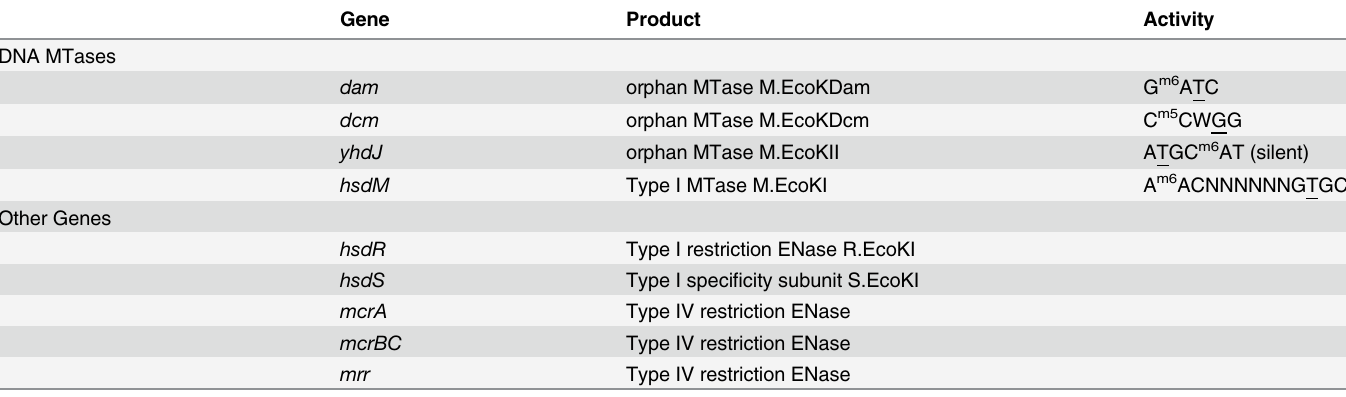
Table 2. DNA restriction-modification genes in E . coli K-12 MG1655.